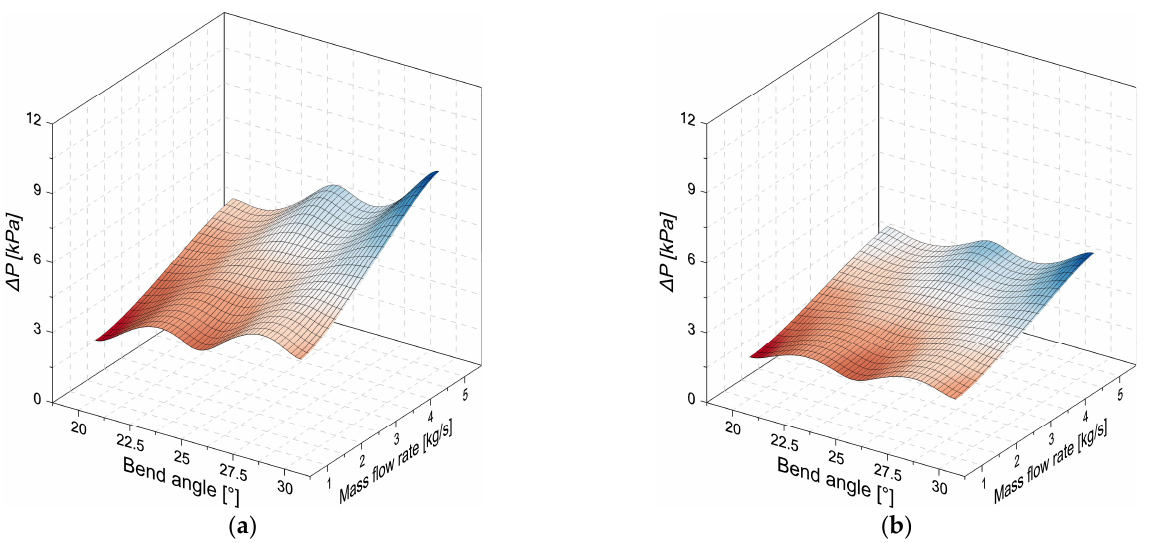
Figure 13. Effect of bend angle on pressure drop: ( a ) conventional zig-zag channel; ( b ) modified zig-zag channel.